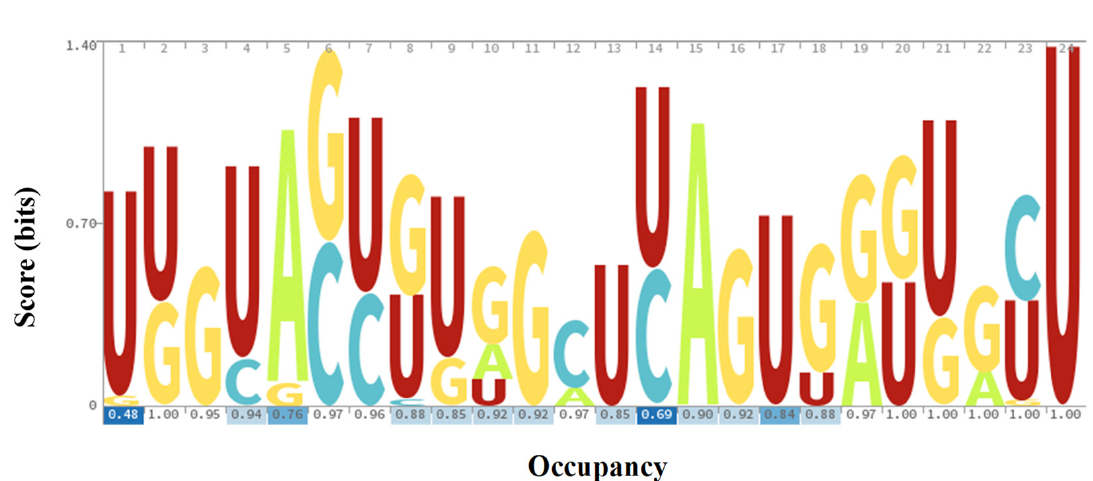
Figure 5. Sequence logo of predicted A. bisporus milRNAs. Logo represents score of weighted counts from a multiple alignment.